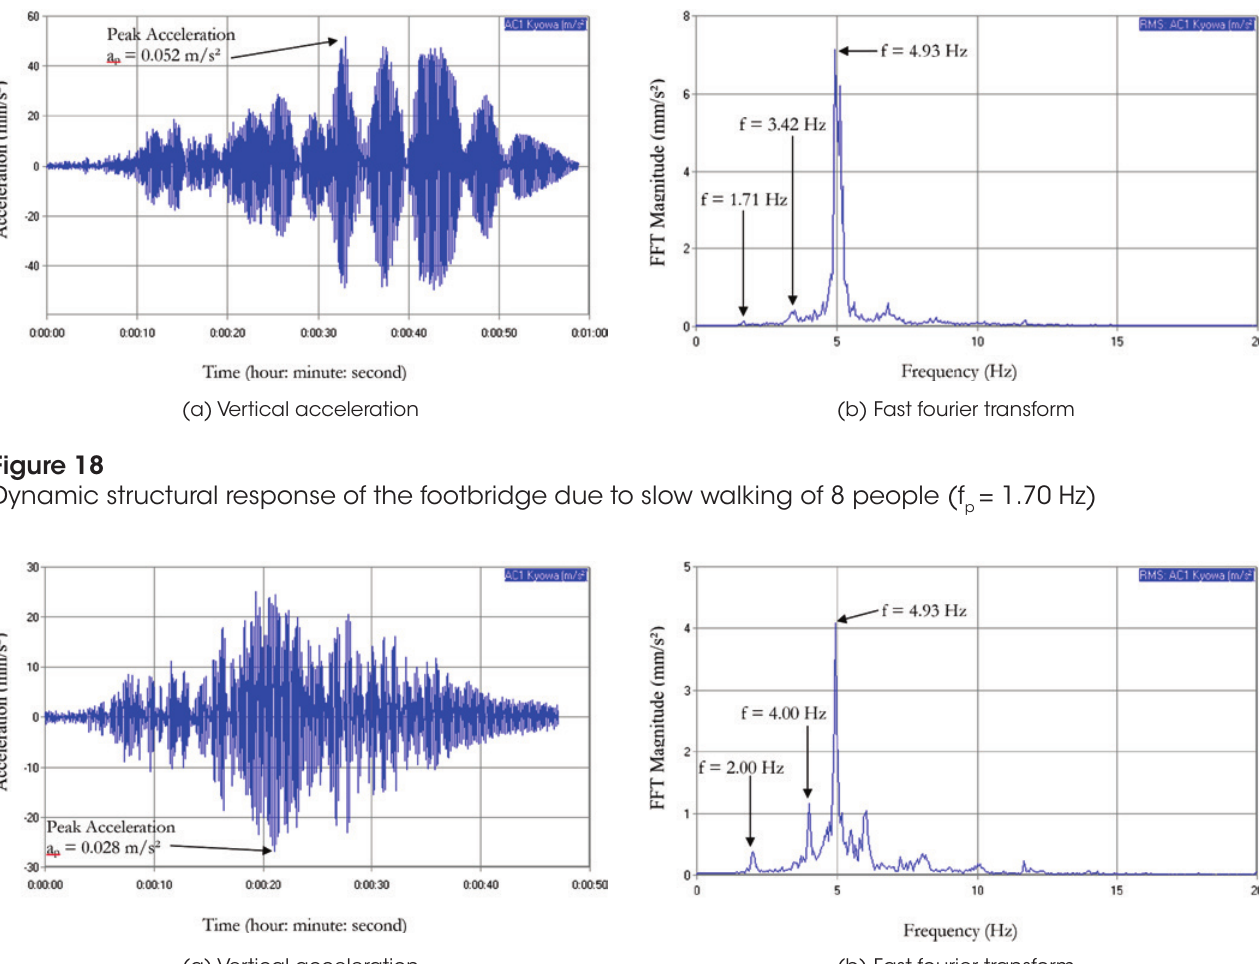
(b) Fast fourier transform = 2.00 Hz) p